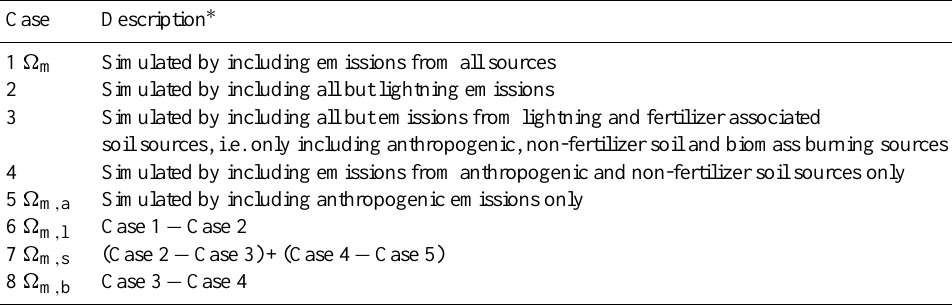
Table 2. Descriptions of VCDs of NO 2 from individual sources derived from model